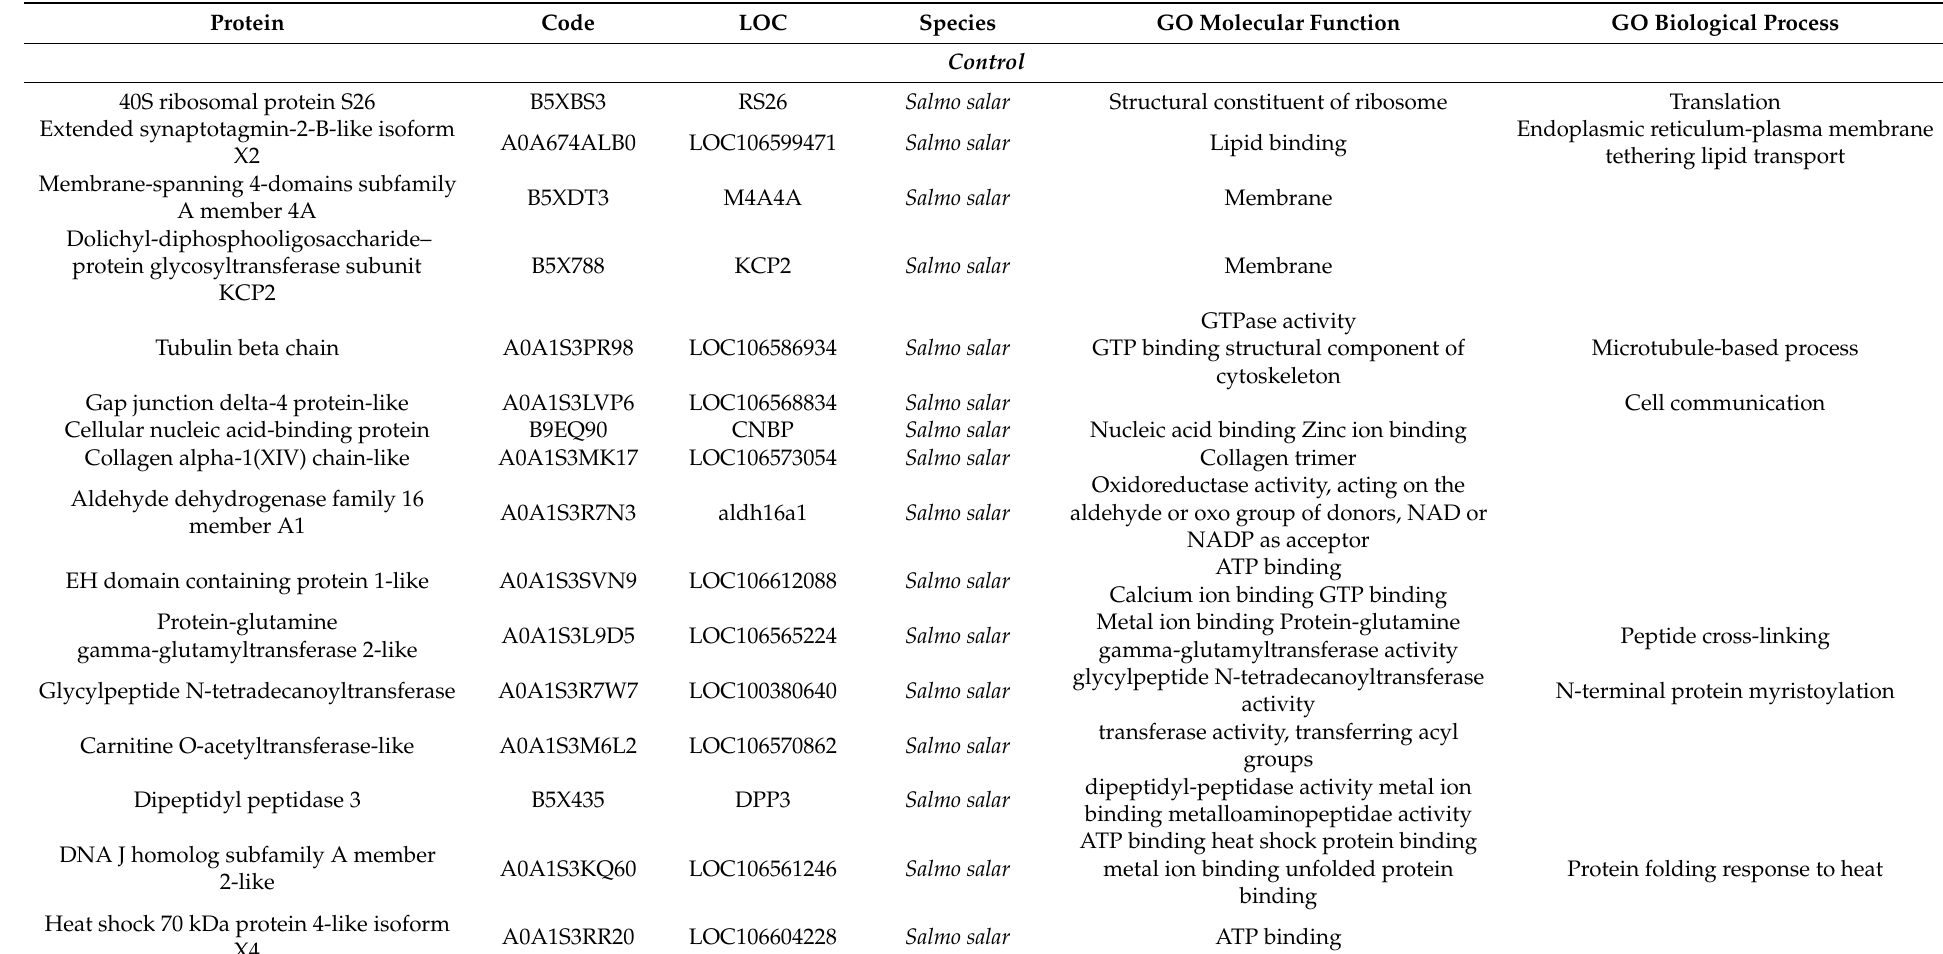
Table 6. List of unique proteins for the control and experimental